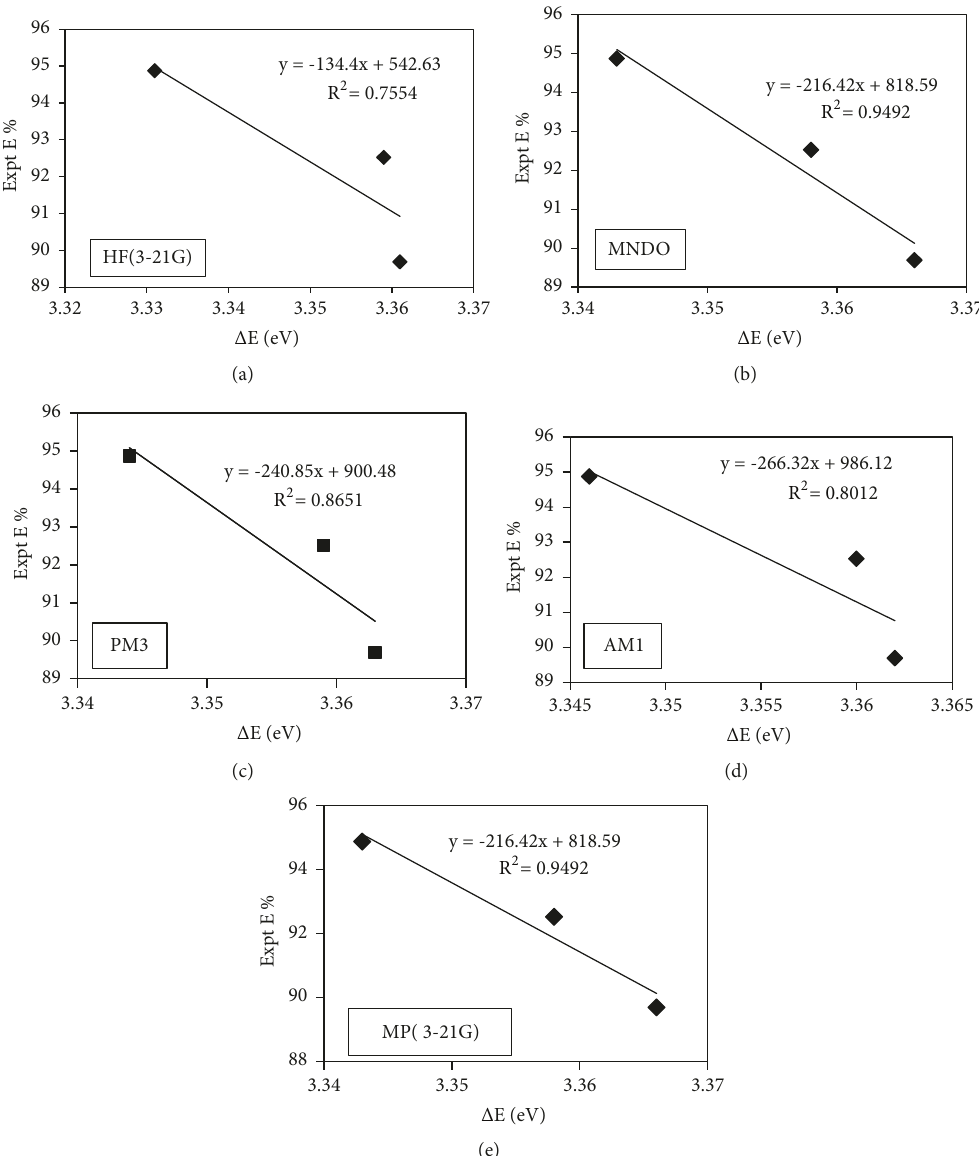
Figure 7: Correlations between experimental inhibition efficiency (Ew%) of synthesized corrosion inhibitors and calculated quantum parameter (energy gap; Δ